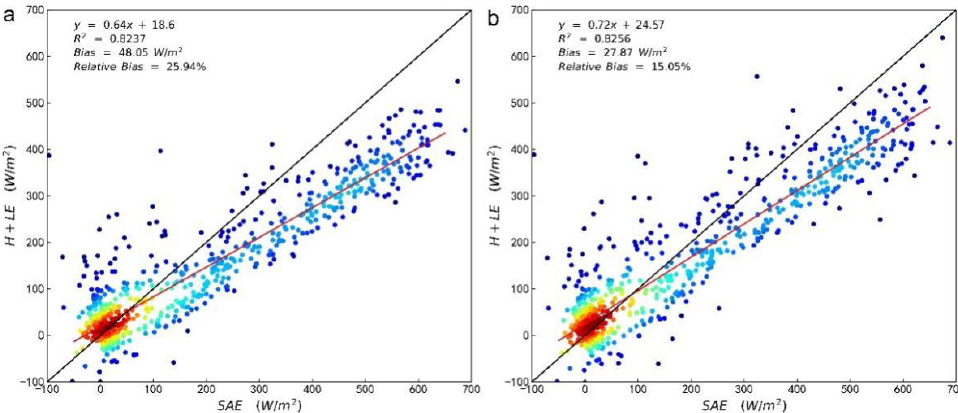
Figure 9. Scatterplots of turbulent flux ( H + LE ) versus surface available energy (( a ): SAE = R n − G 0 ; ( b ): SAE = R n − G 0 − H A − LE A ); Slopes of red lines represent the near-surface energy closure ratio at the FOF from 11 July 2017, to 26 July 2017 and color indicates the density of scatter points (left: without considering horizontal thermal advection; right: considering horizontal thermal advection).